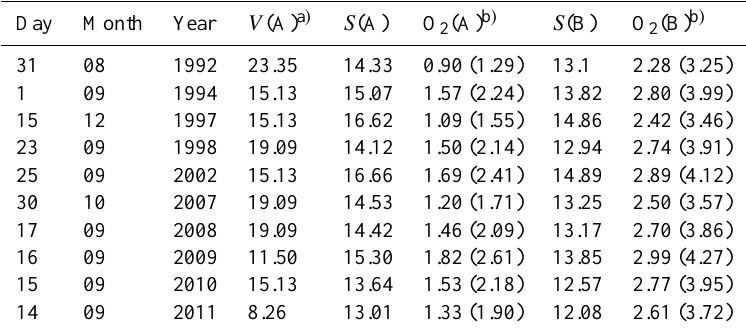
Table 1. Volume, V (A), mean salinity, S (A), and mean oxygen concentration, O 2 (A), of hypoxic water observed in the Arkona Basin during the period 1990–2011. Also shown are estimated salinity, S (B), and oxygen concentration, O 2 (B), when the water reaches 60m depth in the Bornholm